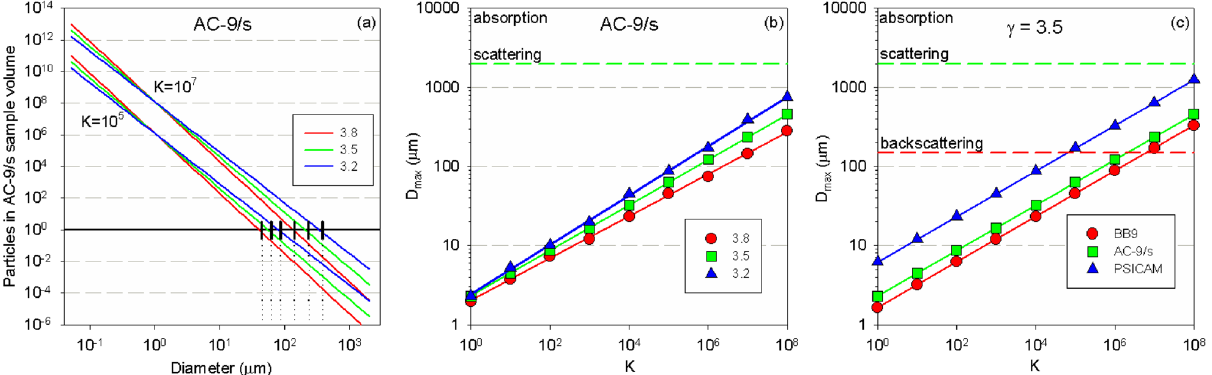
Figure 5. ( a ) Scaling PSD by sensor sample volume enables identification of the maximum particle diameter